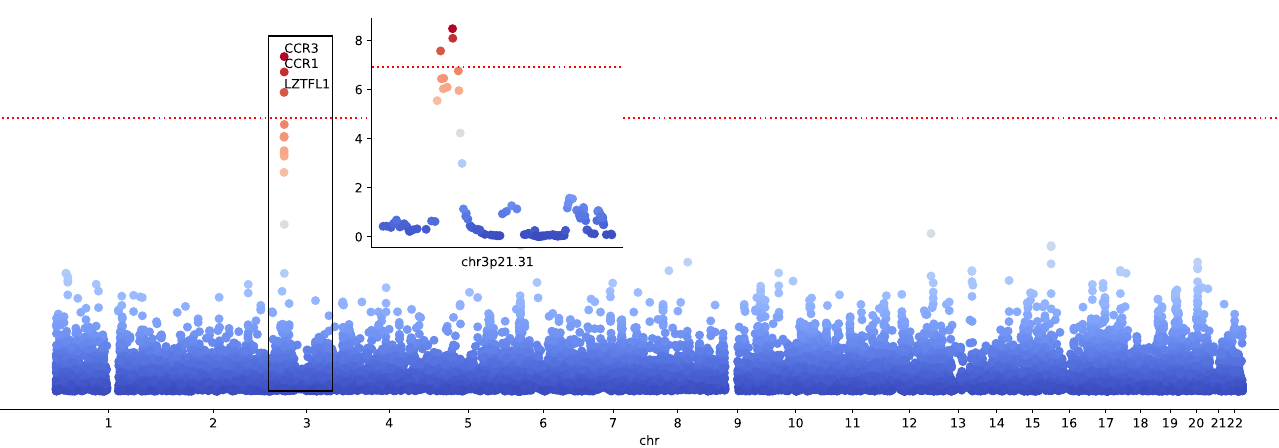
Fig 5. Manhattan plot for cross scoring very severe confirmed COVID-19 with medication class M05B for coherence. Data points correspond to genes. The dotted red line marks a Bonferroni significance threshold of 1.18 × 10 − 7 (0.05 divided by the 18453 genes tested and 23 drug classes). The inlay plot shows a zoom into the relevant locus chr3p21.31.